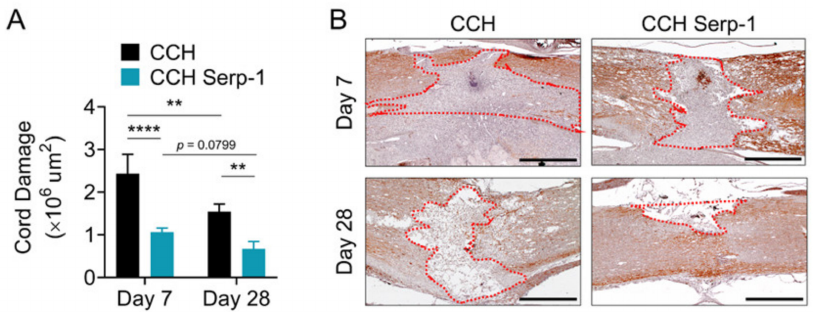
Figure 2. Serp-1 delivered by chitosan-collagen hydrogel reduces cord damage in rat SCI. ( A ) Quantification of cord damage area as measured by loss of neurofilament (NF-M) staining for post-SCI treated with 50 µ L chitosan-collagen hydrogel alone or 50 µ L chitosan-collagen hydrogel with 100 µ g Serp-1 at days 7 and 28 after injury. Mean and standard error are presented. Statistics performed by two-way Analysis of Variance (ANOVA) with Fisher’s Least Significant Di ff erence (LSD) post hoc where ** p < 0.01 and *** p < 0.0001. ( B ) Representative immunohistochemical staining (brown) of NF-M of conditions quantified in panel A. Dotted red area illustrates representative examples of quantified NF-M-negative areas. Boundaries defined are based on continuous tissue outside of the injury area and do not include excessive “spill over” which extend beyond the normal spinal cord boundaries (e.g., day 7 chitosan). Scale bars are 500 µ m.